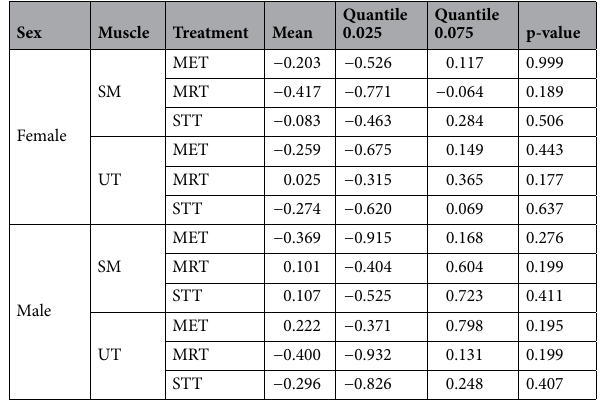
Table 7. Sex-specific analysis of frequency. SM = superficial masseter muscle; UT = upper trapezius muscle; MRT = myofascial release technique; MET = muscle energy technique; STT = soft tissue technique; SD = standard deviation. P-value for the simple